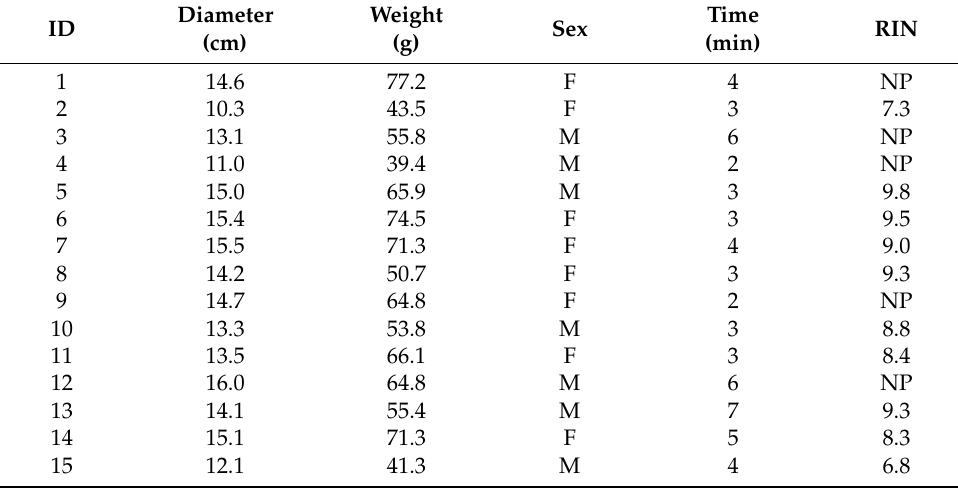
Table 1. Data for Asterias rubens ( n = 15) at time of sampling, including diameter (cm), wet weight (g), sex, time in 75 g/L magnesium chloride solution until non-reactive to stimuli (minutes), and